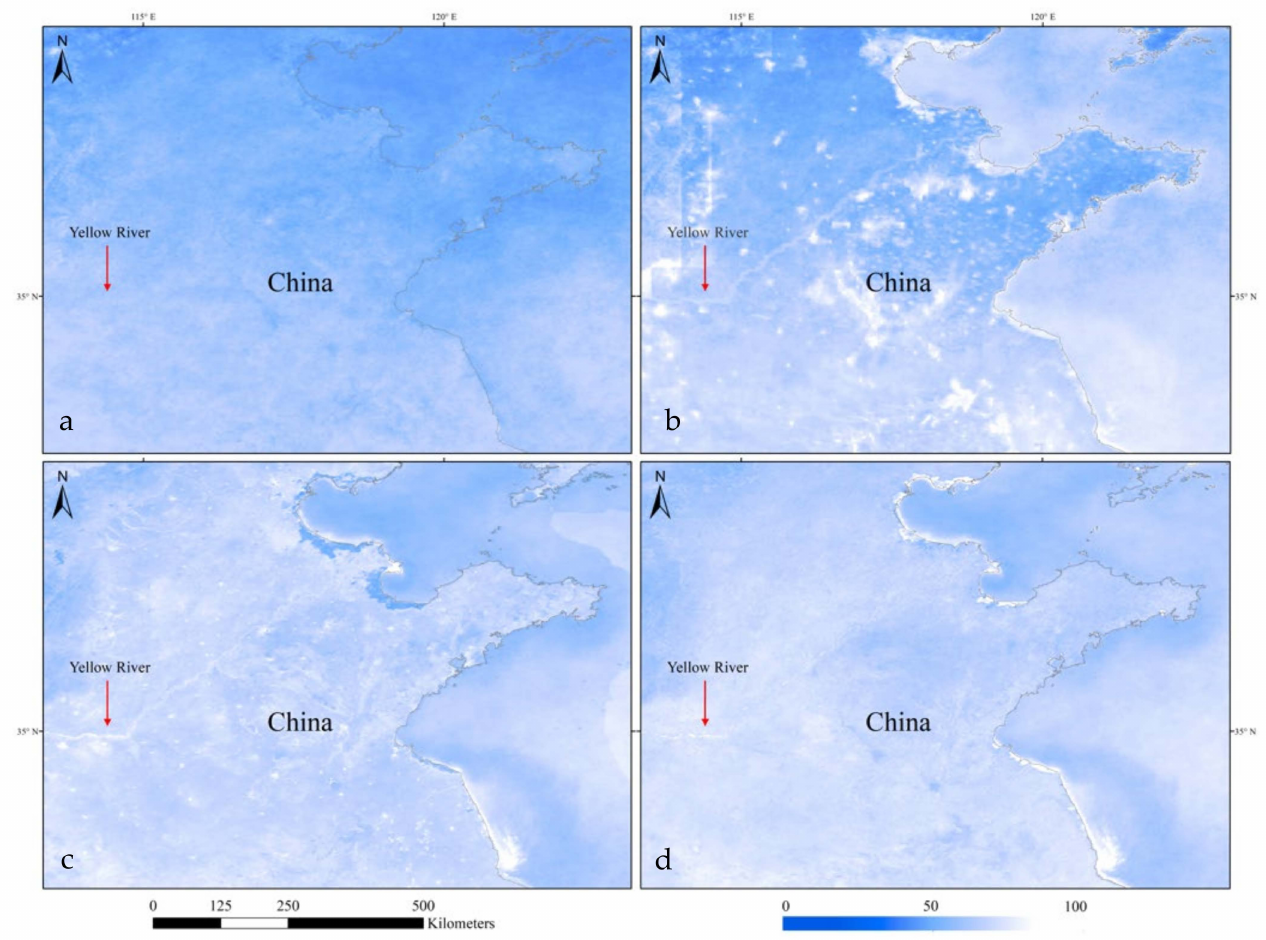
Figure 8. Annual mean cloud frequency (%) for 2001 based on Collection 5 ( a ) and 6 ( b ) of MOD09 cloud mask and Collection 5 ( c ) and 6 ( d ) of the MOD35 cloud mask. The red arrow points to the Yellow